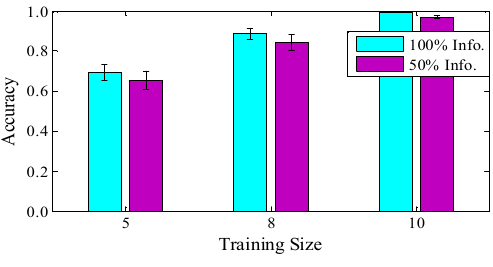
Figure 11. Impact of training strategy.